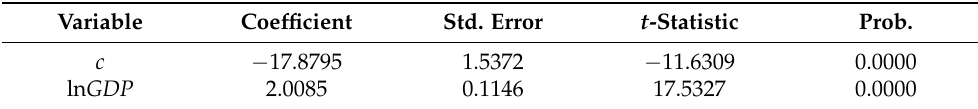
Table 2. Regression estimation results of cointegration equation